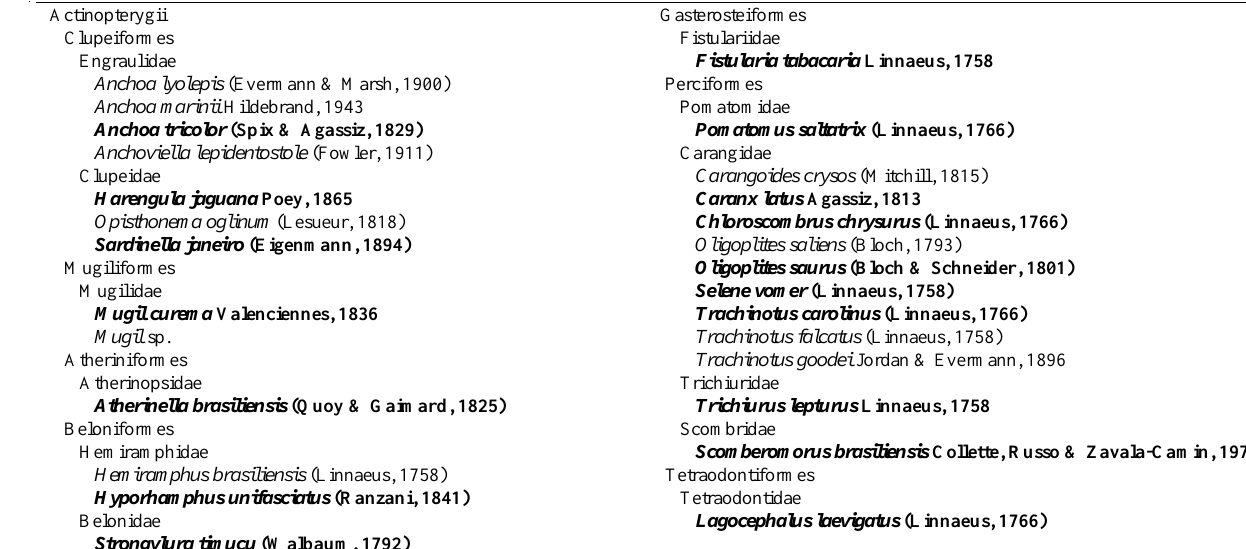
Table 1. The 27 nektonic fish species recorded from the São Sebastião Channel, southeastern Brazil (ordination is based in Nelson, 2006). The “morphotypes” chosen for this study are in